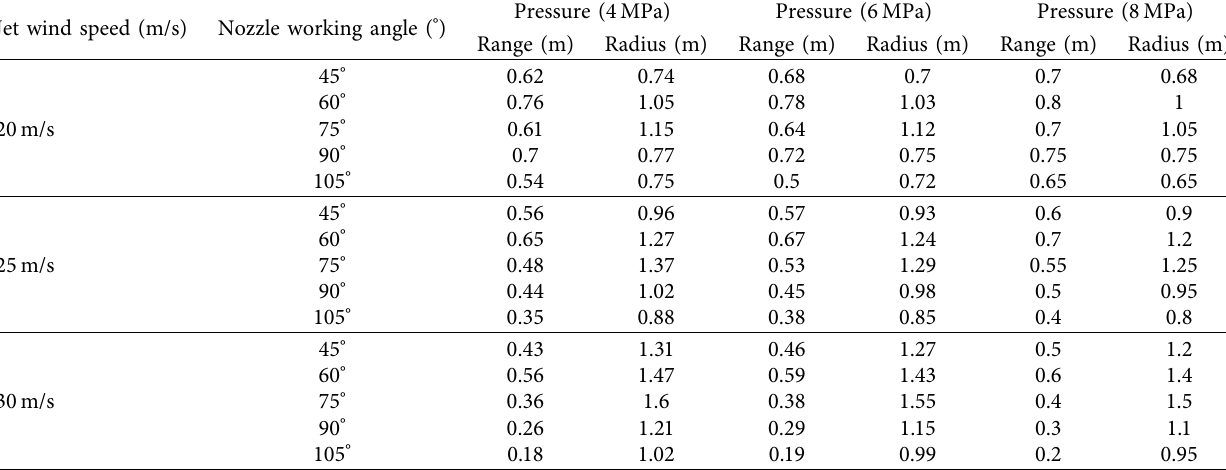
Table 1: Atomization performance data